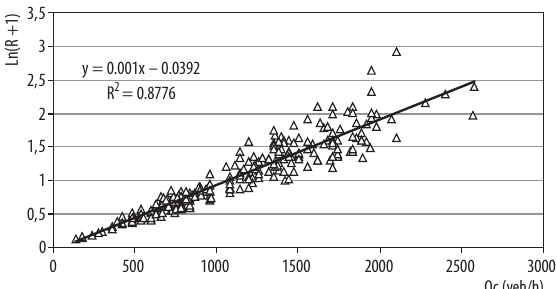
Fig. 5. Results of the regression analysis of all data on the multi-lane traffi c